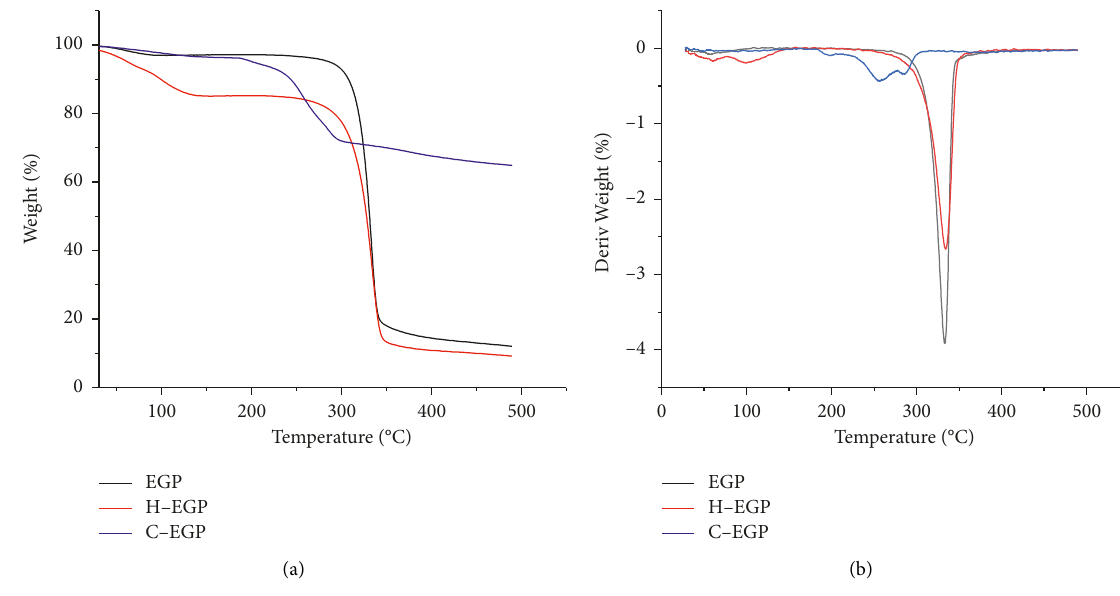
Figure 4: TG (a) and DTG (b) curves of EGP and its derivatives. Table 2: Thermogravimetric analysis of the EGP and its